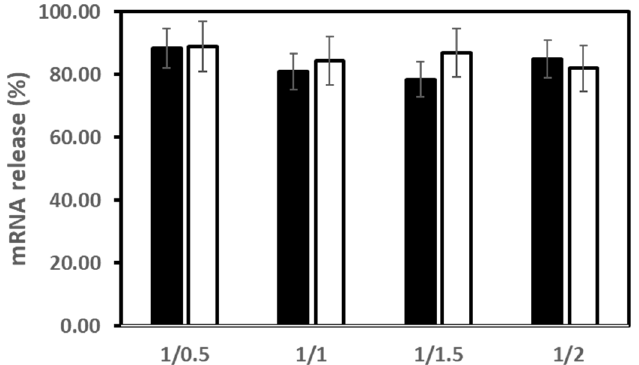
Figure 5. mRNA release from LX. mRNA was first complexed with (black bar) 2 / DOPE (lipid molar ratio 2/1) or (white bar) 3b / DOPE (lipid molar ratio 2/1) liposomes at various mRNA/L ratio. Then, LX were incubated in the absence or the presence of 90 µM dextran sulphate of 500 kDa (DS) for 1 hr before electrophoresis on a 0.6% agarose gel. Gel running buffer was TAE (40 mM Tris-acetate, 1 mM EDTA) and mRNA gel was stained with ethidium bromide (0.5 µg/mL). mRNA fluorescence was revealed under UV lamp and quantified by image J. The percentage of mRNA release was determined from the intensity of mRNA that migrated after DS treatment of LX and the intensity of the same amount of free mRNA.